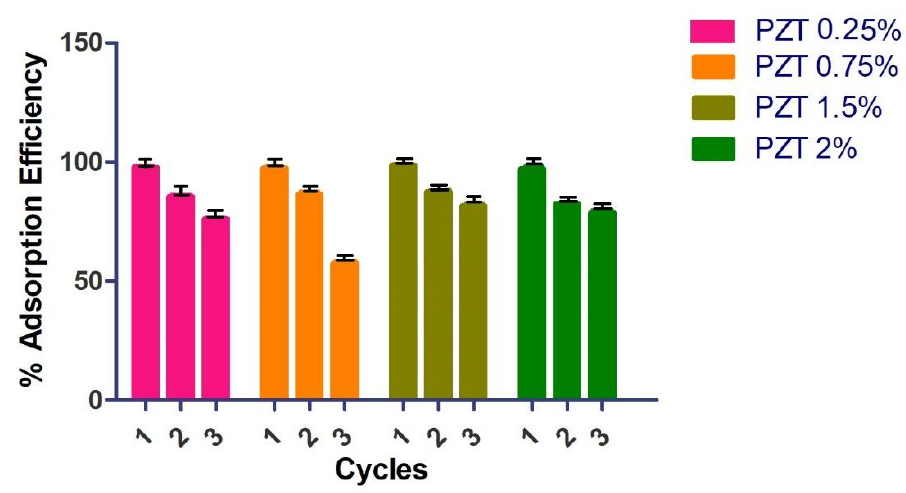
Figure 7. Effect of desorption cycles on methylene blue removal (MB concentration = 200 mg/L, nanocomposite PZT content = 20 mg/100 mL, T = 25 °C and 18 min).